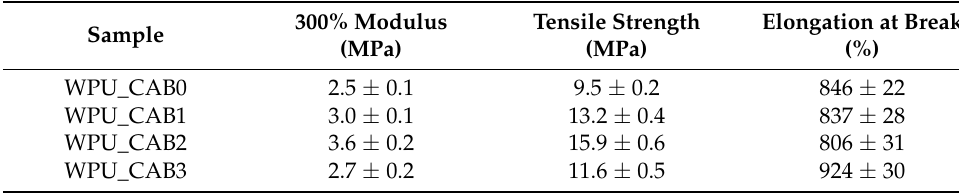
Table 4. Mechanical properties of WPU